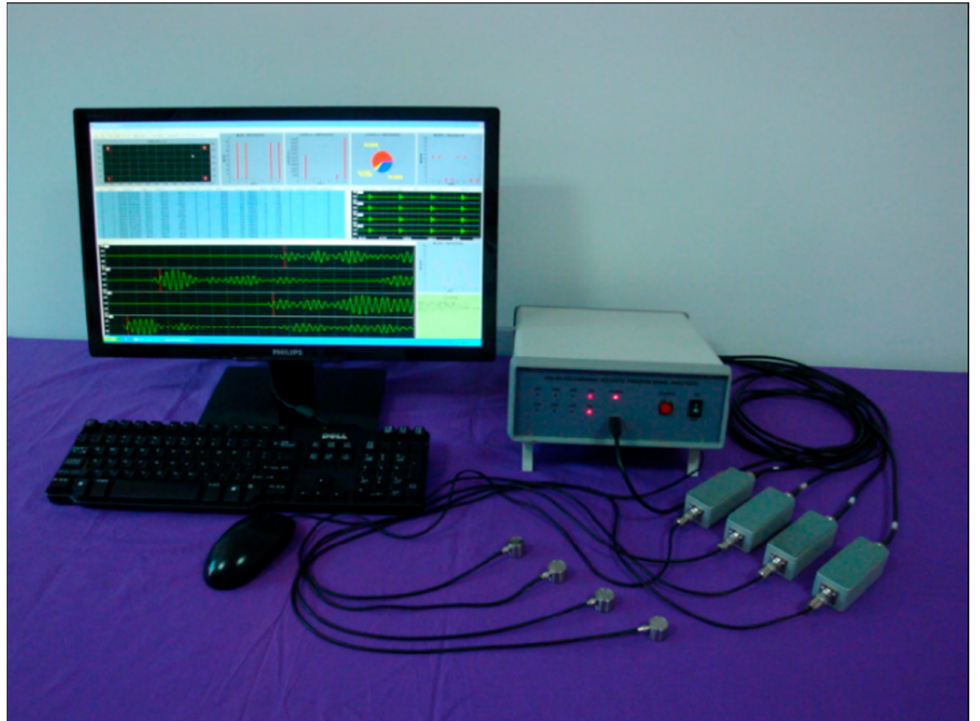
Figure 1. 8- channel DS2-B series acoustic emission testing